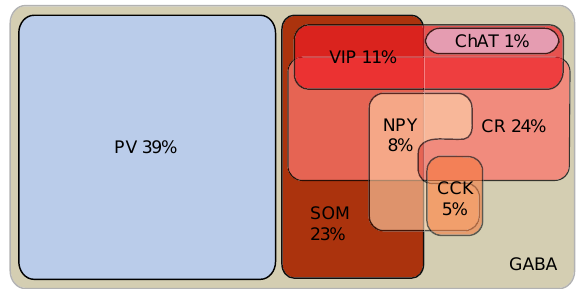
Figure 8. Distribution of cortical interneuron markers in adult mouse primary visual